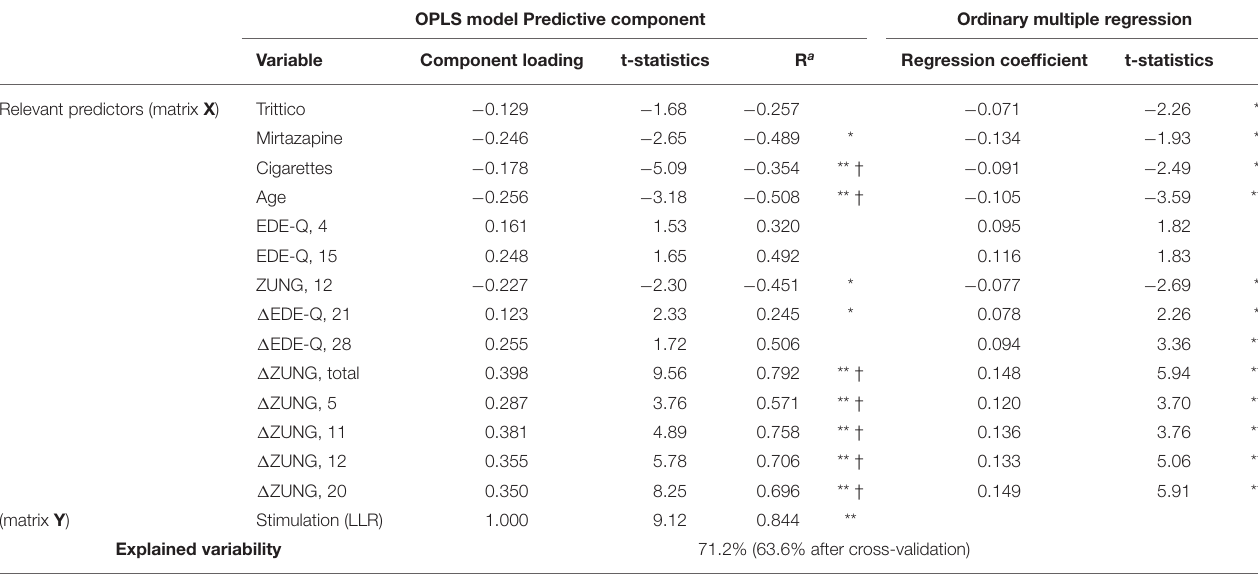
TABLE 4 | Relationships between the effect of stimulation (stimulated vs. non-stimulated patients, logarithm of the likelihood ratio, and LLR) and other parameters for the predictive component as evaluated by the OPLS model (for details, see Statistical Analysis